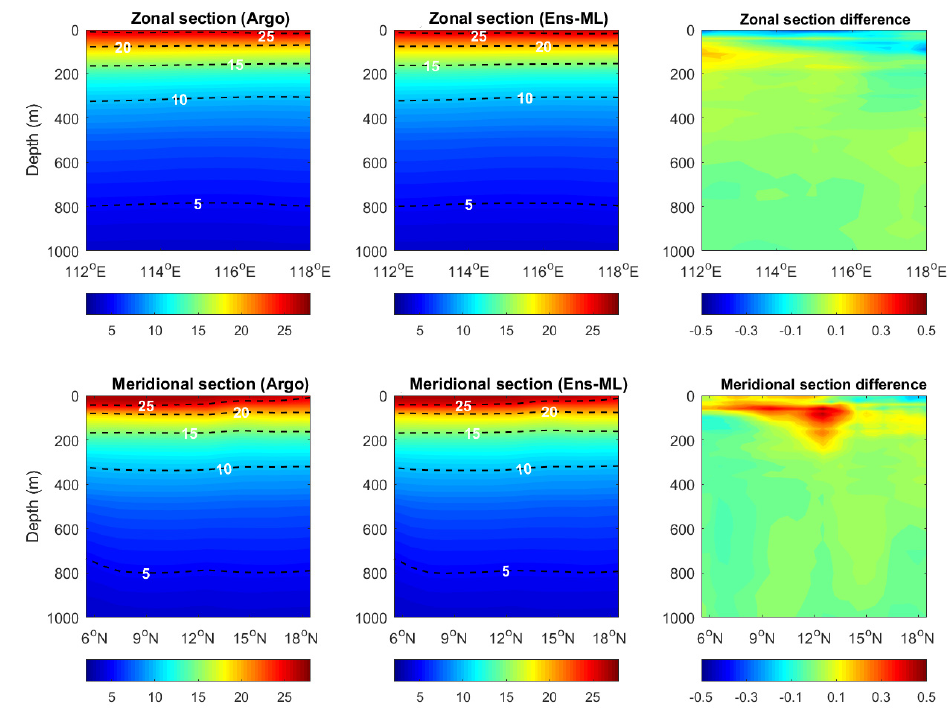
Figure 7. Argo-derived OSTS ( left panel), Ens-ML model estimated OSTS ( middle panel) and their differences (Argo minus Ens-ML, right panel) along the zonal and meridional sections in 2019.